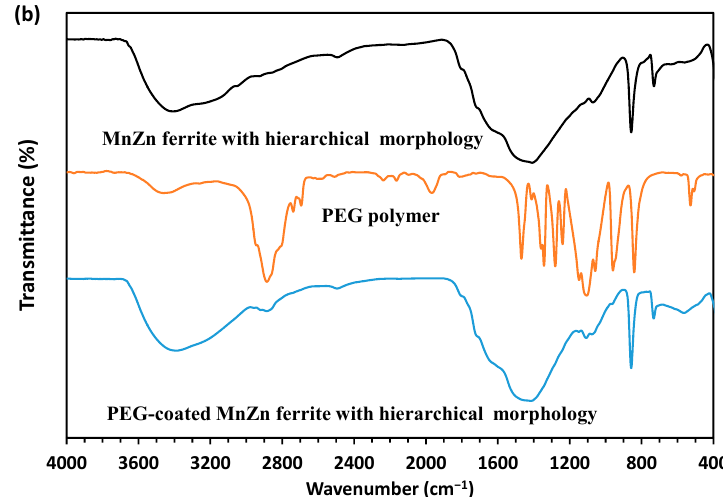
Figure 6. ( a , b ) FTIR spectra of bare, PEG-coated MnZn ferrite nanoparticles with different morphologies.